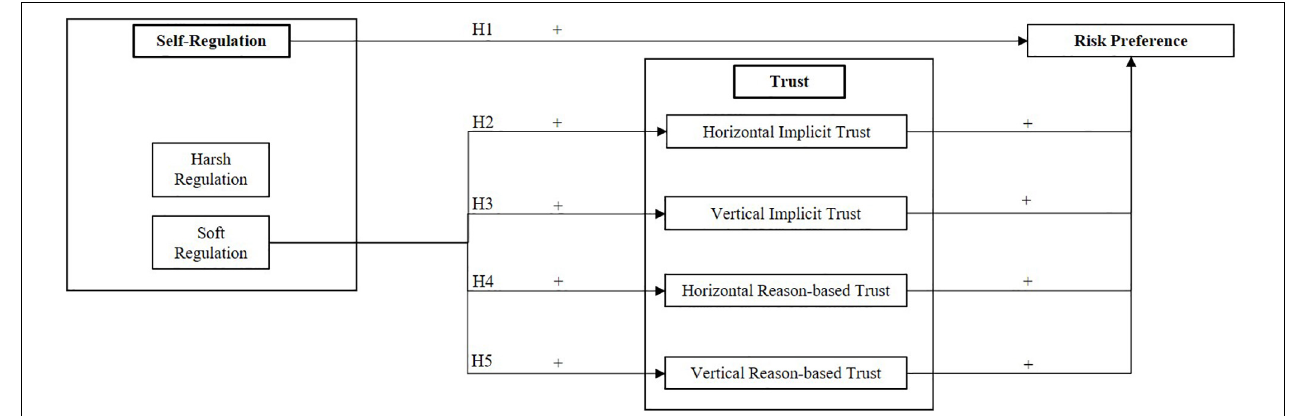
FIGURE 1 | Research